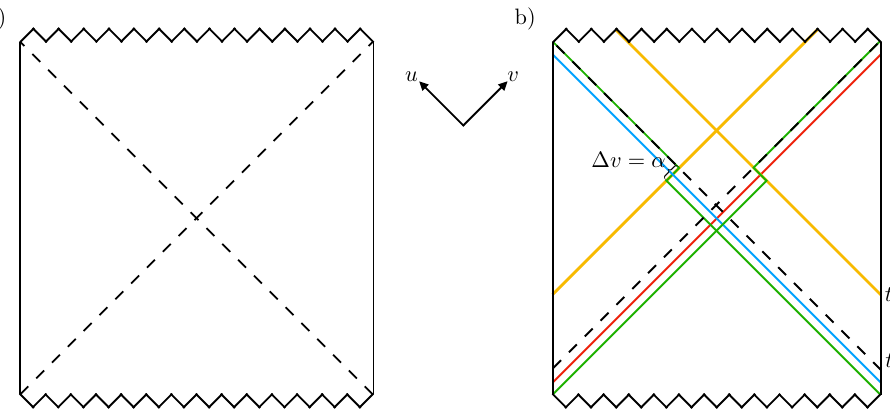
Figure 2 . Penrose diagrams for the AdS wormhole, with future event horizons illustrated by the black dashed lines. In panel a), the standard AdS black hole geometry is depicted, which in D = 3 dimensions has the BTZ metric given in eqs. (3.4) and (3.5). In panel b), the spacetime has been modi(cid:12)ed by the double-trace deformation at time t w , resulting in a negative null energy shock wave in the bulk (yellow line). This shock wave has the e(cid:11)ect of moving the apparent horizon inward (green line), rendering the wormhole traversable: signals sent from the left boundary before t f can reach the right boundary (red line) and vice versa (blue